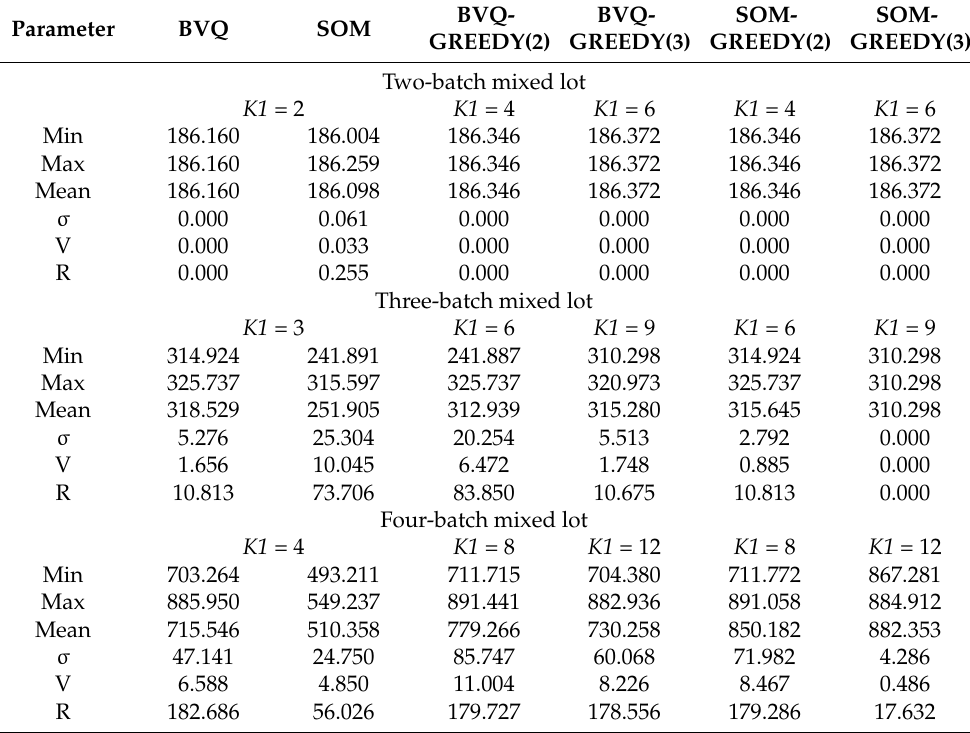
Table A15. Objective function value summarized after 30 attempts (Manhattan distance, initialization by